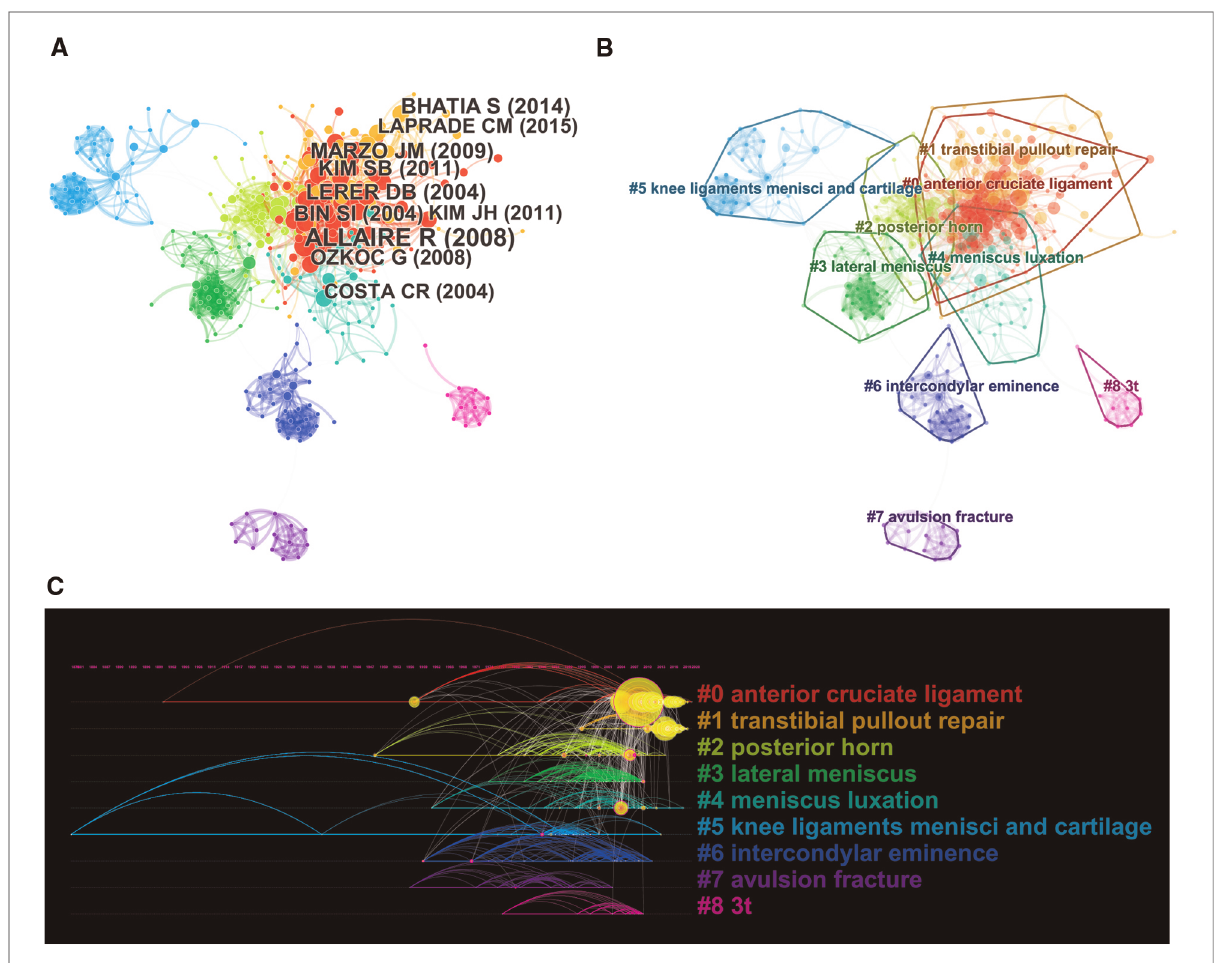
FIGURE 6 The co-citation analysis of references in publications on meniscal root tears research. ( A ) Co-citation network of references. ( B ) Cluster map of co- citation network of references. ( C ) The timeline view of co-citation network of